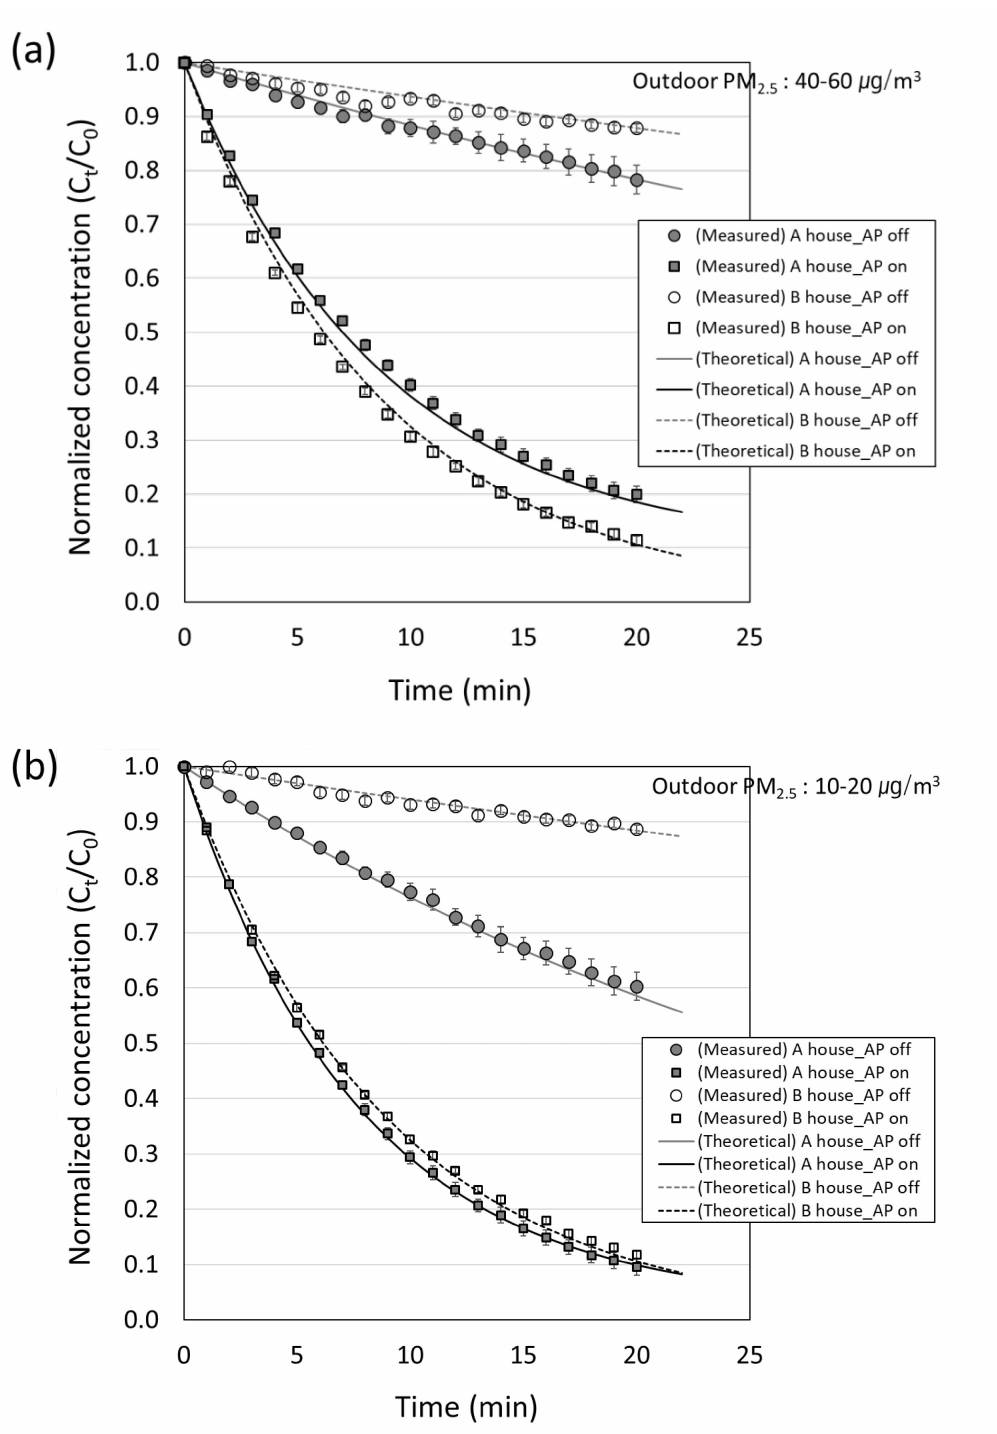
Figure 6. Normalized number concentration of 0.3–1.0 µ m particles with operations of an air purifier on and off at two test houses according to time. Outdoor PM2.5 concentrations are in the range of ( a ) 40–60 µ g/m 3 and ( b ) 10–20 µ g/m 3